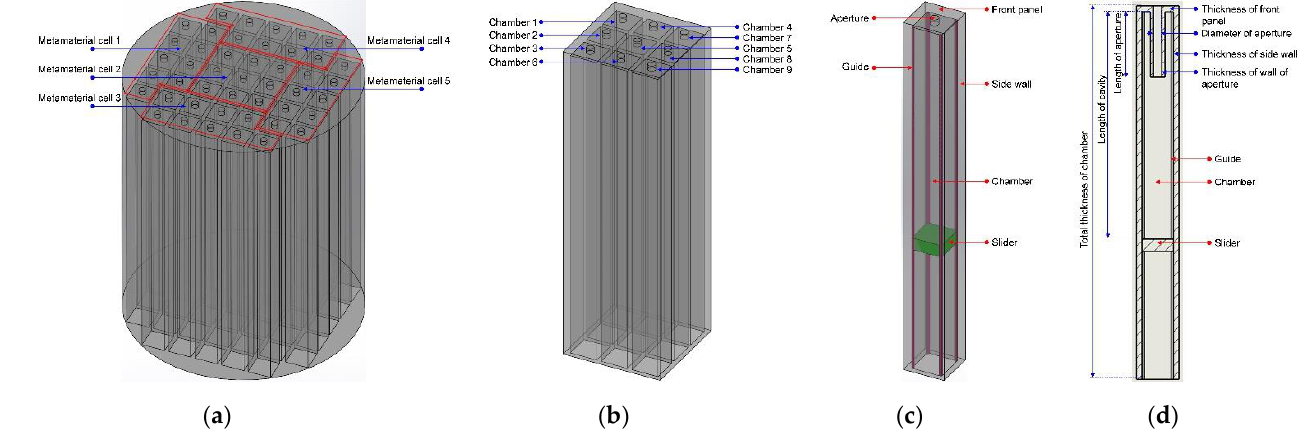
Figure 1. A schematic diagram of the APH-AM structure. ( a ) 3D model of the whole structure; ( b ) 3D model of a metamaterial cell; ( c ) 3D model of a single adjustable chamber; ( d ) 2D sketch and parameters of a single adjustable chamber.